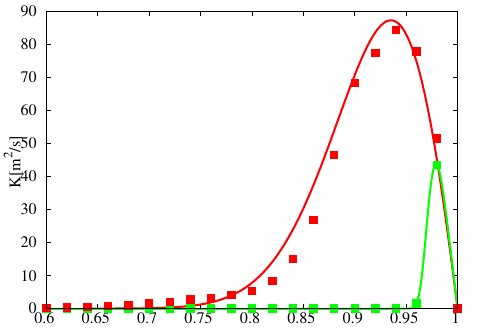
Figure 4. Diffusivity profiles used in the experiments. The symbols Fig. 3. Average GLOBO profiles of ρ (green Fig. 4. Diffusivity profiles used in the experiments. The symbols symbols) and φ/g (blue symbols) as a function of vertical coordinate represents the data from GLOBO and the lines their fitting function. σ , and their ana- represents the data from GLOBO and the lines, their fitting function. lytical fits (Eq. 23 and Eq. 24, lines of the same colors). The ‘average’ profile is shown in red, while the ‘peaked’ profile is The “average” profile is shown in red, while the “peaked” profile is shown in green. The functional form of both profiles is described shown in green. The functional form of both profiles is described by by Eq. (26). Eq. (26).